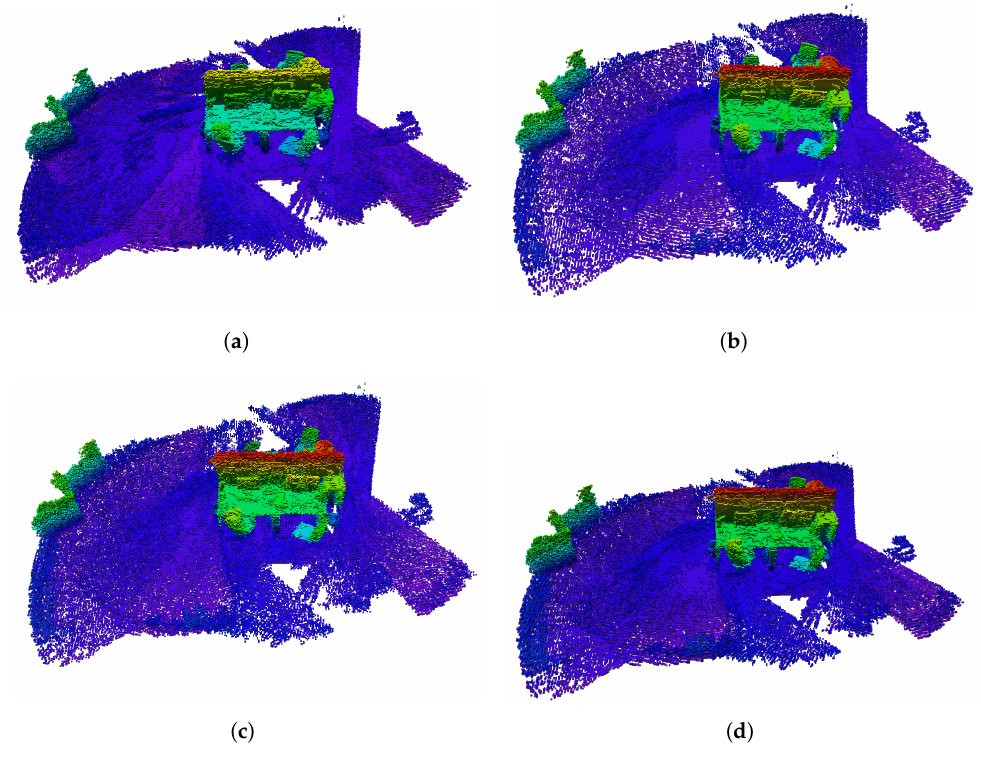
Figure 11. Benchmark outputs at 0.025 m grid resolution. ( a ) OctoMap. ( b ) Nanomap No Filter.